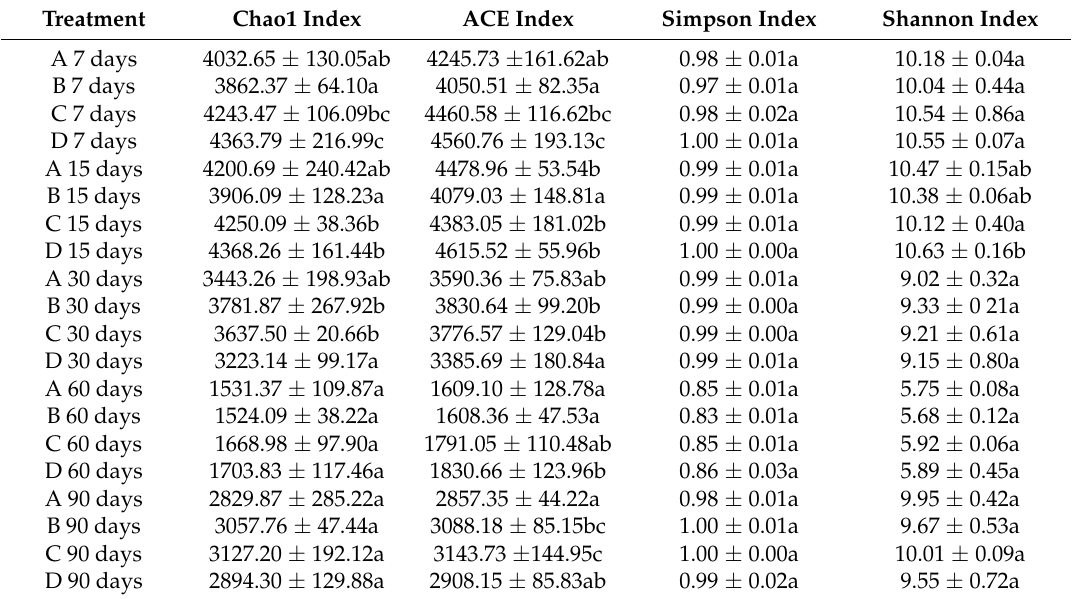
Table 3. Soil bacterial abundance and diversity indices with different concentrations of graphene and different incubation